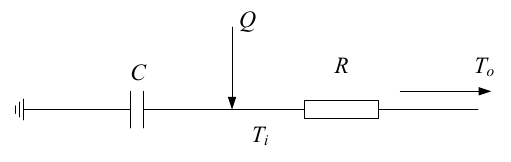
Figure 2. The first-order ETP model.